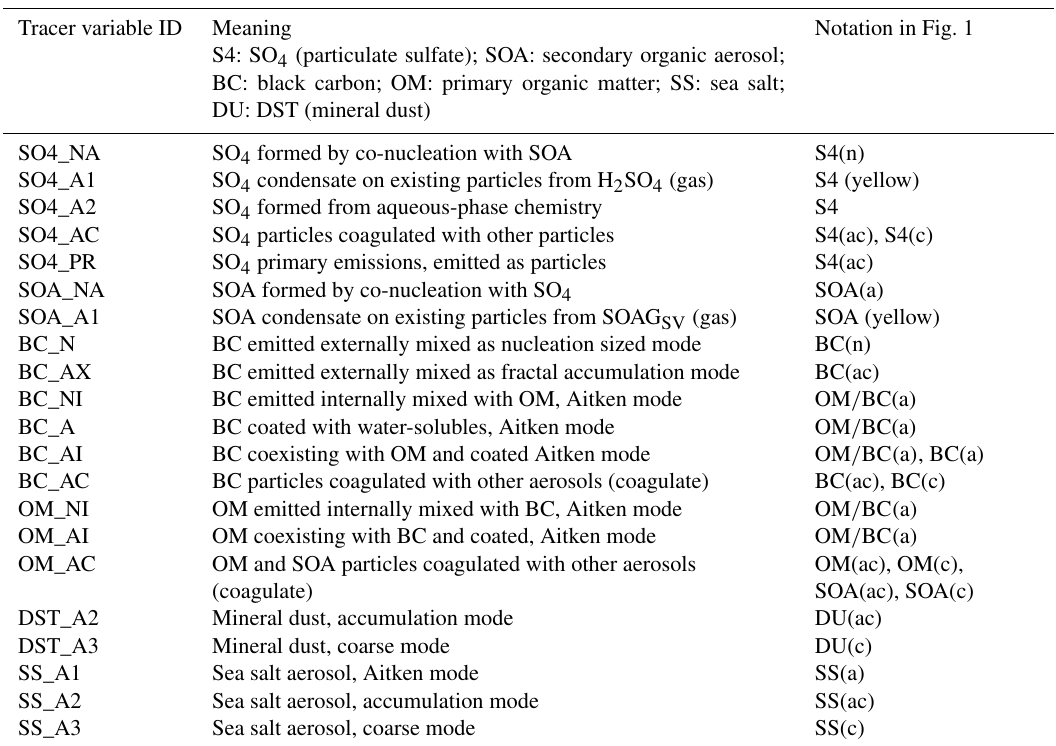
Table 1. Transported aerosol tracers included in OsloAero5.3. The aerosol precursor and oxidant gas tracers transported by the model are SO 2 , H 2 SO 4 , DMS, isoprene, monoterpene, SOAG_LV, SOAG_SV, and H 2 O 2 . Tracer variable ID Notation in Fig.